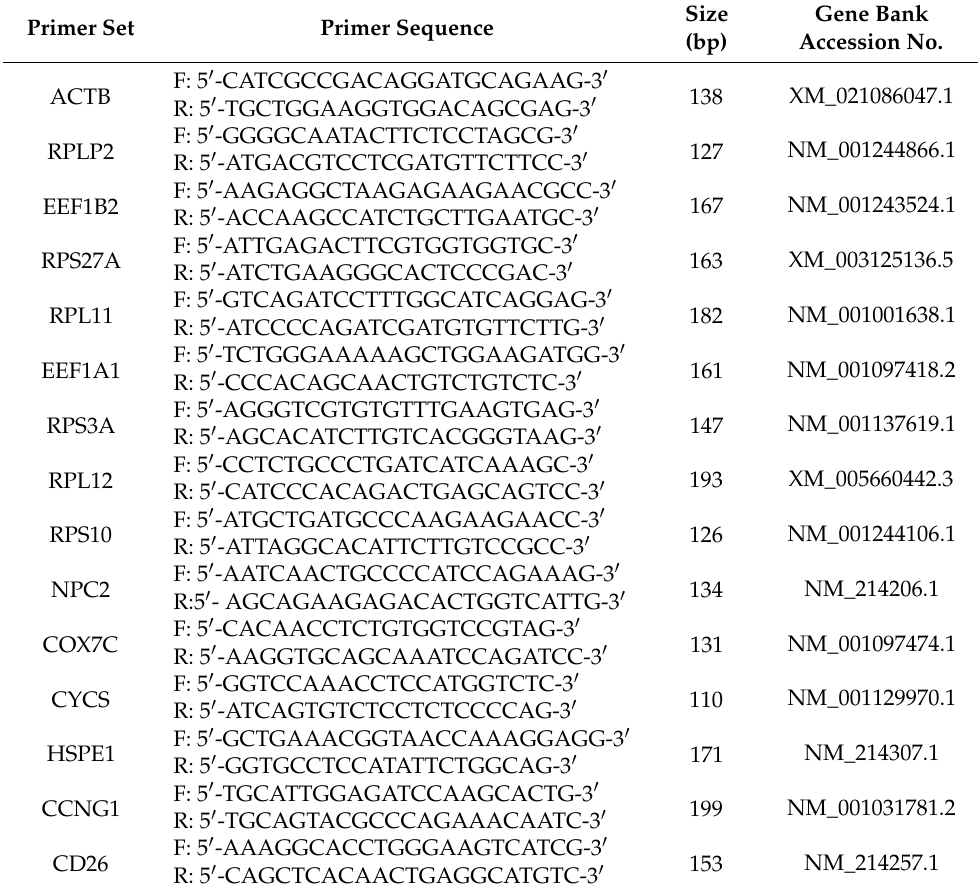
Table 1. Primers used for